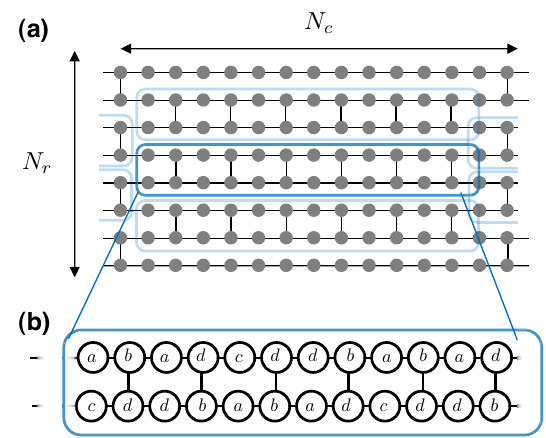
FIG. 2. A geometric arrangement of qubits for the solvable example of a generator state for an ε -approximate k -design. The generator state can be efficiently prepared by time-independent Hamiltonian evolution. (a) A graph representing the connectiv- ity of N = N r × N c qubits arranged in a two-dimensional square lattice. Qubits are represented by vertices (gray circles) and a pair of neighboring qubits interact via an Ising coupling when- ever an edge (black line) exists between them. The connectivity exhibits a periodicity, where the two-row 12-column unit cell (blue box) is repeated in a brick-wall layout. (b) The connec- tivity and grouping of qubits within a single unit cell. Each qubit belongs to one of the four distinct groups as indicated by labels { a , b , c , d }